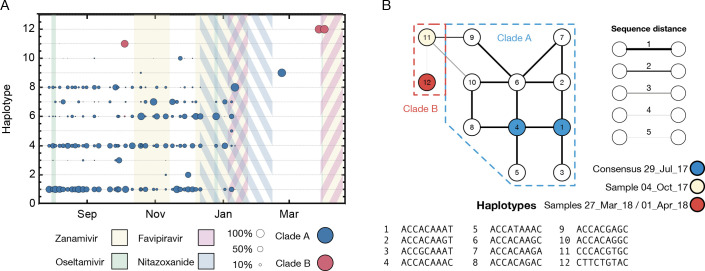
Haplotype reconstruction for data describing the haemagglutinin segment of the virus.(A) Sub-consensus structure of the viral population inferred via a haplotype reconstruction algorithm using data from the haemagglutinin segment. A division of sequences into two clades is visible, with samples including largely distinct viral genotypes. The area of each circle is proportional to the amount of virus in each clade. Haplotypes reaching a frequency of at least 10% in at least one time point are shown. Haplotypes spanned the loci 258, 261, 364, 451, 521, 541, 635, and 641 in the HA segment. (B) Evolutionary relationship between the haplotypes; clade B is distinct from and evolves away from those sequences comprising the initial infection. Numbers refer to the distinct haplotypes identified within the population.Figure 1—figure supplement 2—source data 1.Reconstructed haplotype frequencies for the haemagglutinin viral segment.